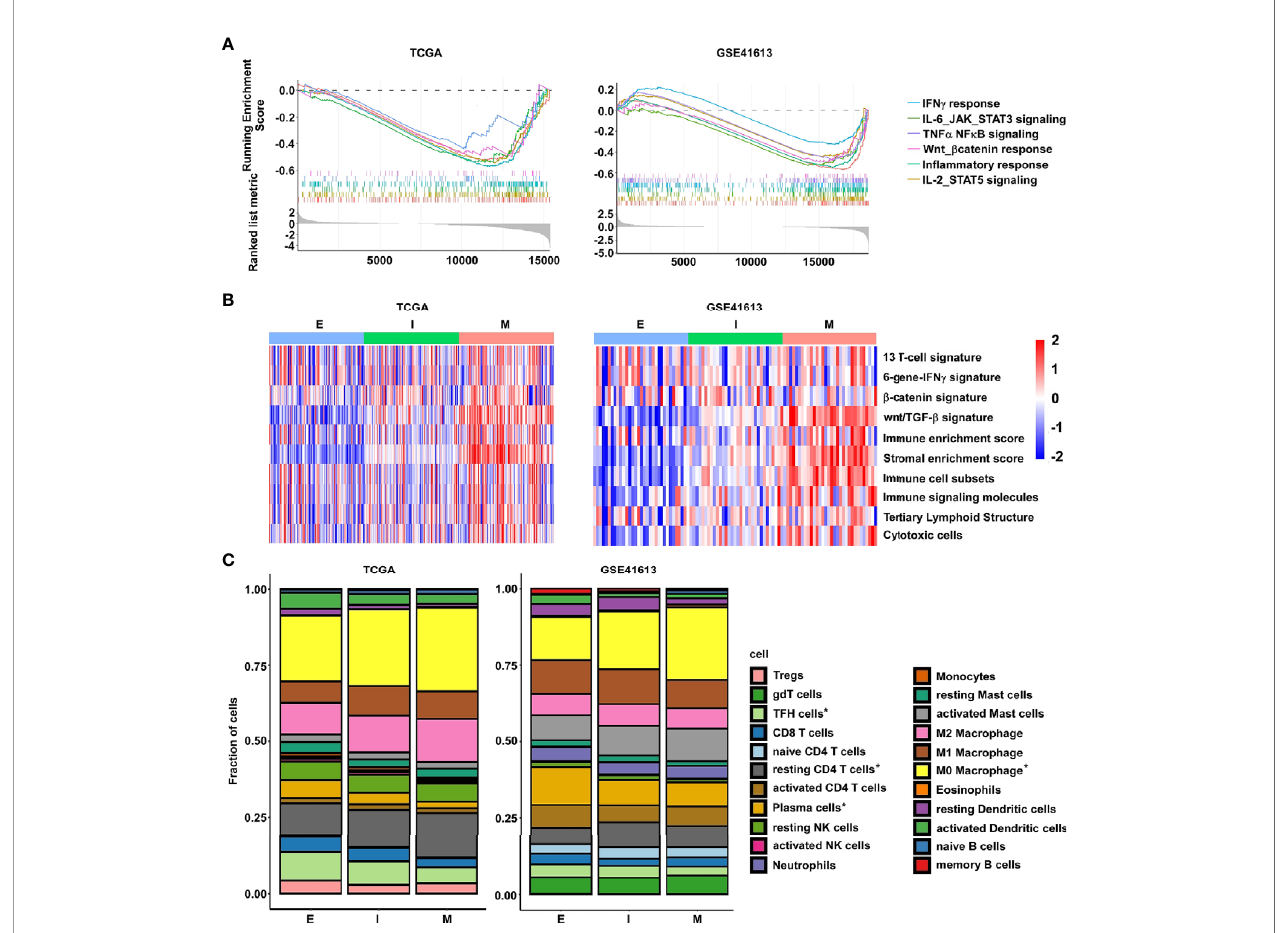
FIGURE 5 | The M-subtype OSCC is highly in fl amed and is associated with an immunosuppressive TME. (A) The enrichment of immune related signaling in M- subtype OSCC are determined by GSEA analysis. (B) The enrichment of immune-related gene signatures in each EMT subtype tumor is performed by ssGSEA analysis. Red, high ssGSEA scores; blue, low ssGSEA scores. (C) The lymphocytes fractions of each EMT subtype were calculated by CIBERSORT. * p value < 0.05, student ’ s t